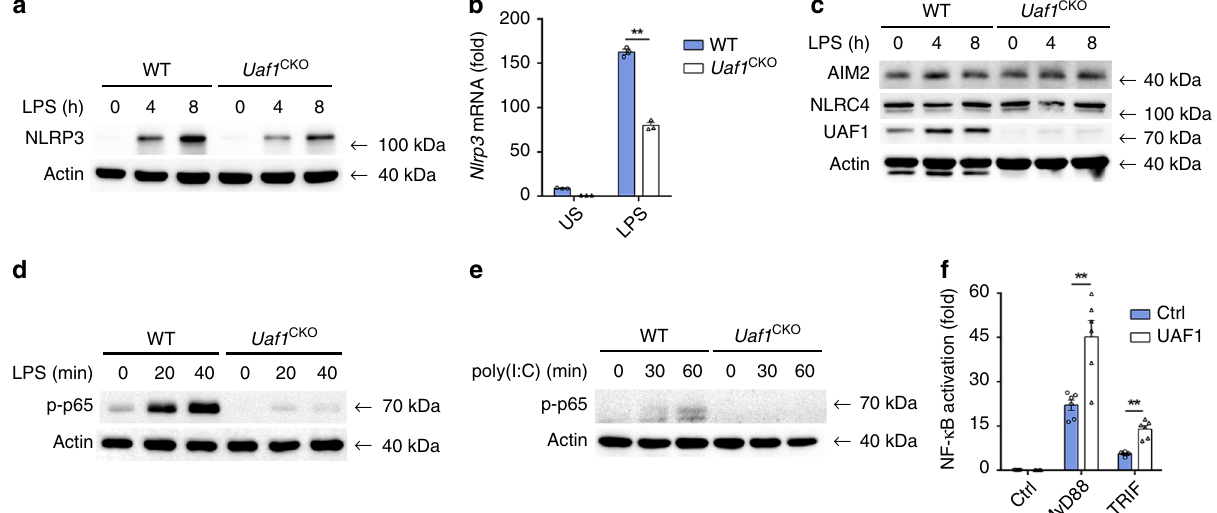
Fig. 2 UAF1 enhances NLRP3 expression. a , c Western blot analysis of NLRP3 ( a ), AIM2 and NLRC4 ( c ) in WT or Uaf1 -de fi cient mouse peritoneal macrophages stimulated with LPS for the indicated time periods. b RT-PCR analysis of Nlrp3 mRNA expression in WT or Uaf1 -de fi cient mouse peritoneal macrophages stimulated with LPS for 2 h (mean ± SEM, two-tailed t -test Uaf1 CKO vs. WT, ** P < 0.0001; n = 3 indepe n dent experiments). d , e Western blot analysis of p-p65 in WT or Uaf1 -de fi cient mouse peritoneal macrophages stimulated with LPS ( d ) or poly(I:C) ( e ) for the indicated time periods. f Analysis of NF- κ B reporter activation using a Luciferase assay in HEK293T cells transiently transfected with NF- κ B reporter plasmid together with MyD88 or TRIF, and UAF1 expression plasmid or empty control plasmid (mean ± SEM, two-tailed t -test UAF1 plasmid vs. empty control plasmid, ** P = 0.0024, <0.0001